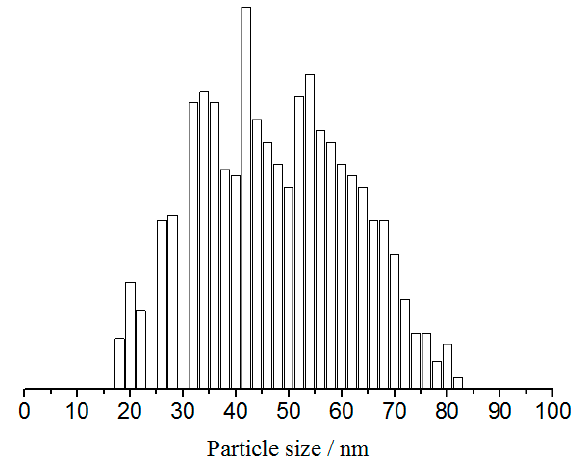
Figure 4. Size distribution of silver particles on the FP/PAN film after laser irradiation.